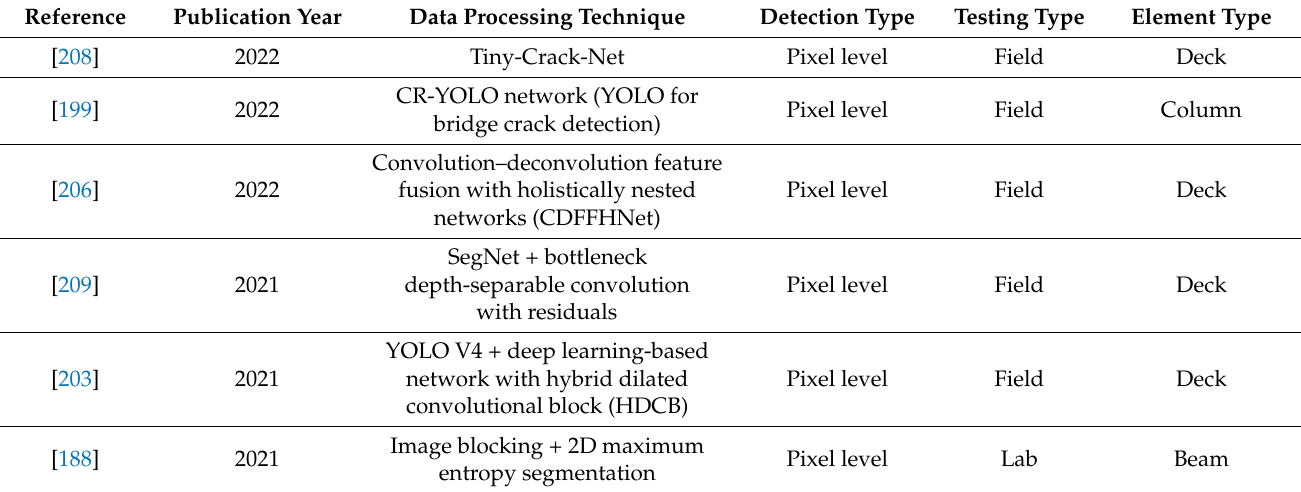
Table 16. Summary of some of the research studies for detection of surface cracks using digital